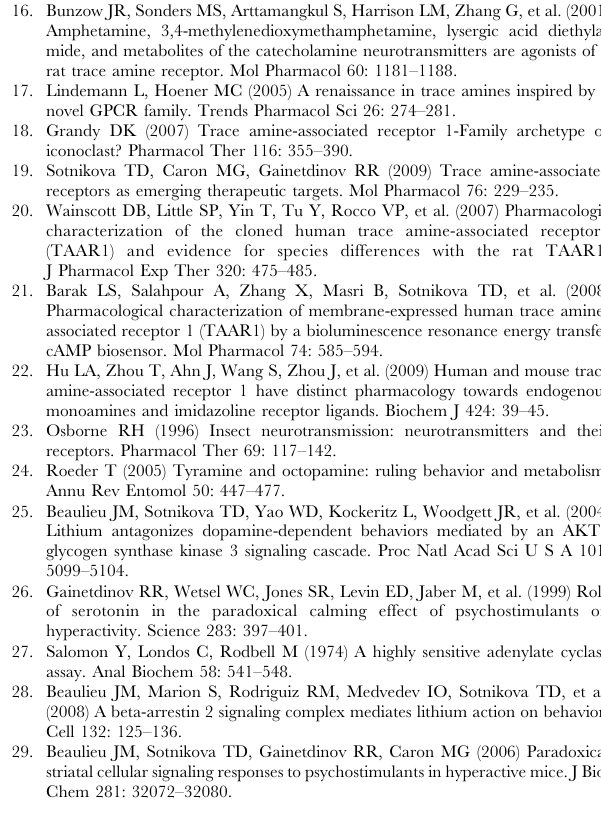
Figure S1 Automated measures of dynamics of abnormal movements induced by 3-MT in wild type mice. Found at: doi:10.1371/journal.pone.0013452.s001 (0.04 MB PDF) Figure S2 Determination of striatal extracellular levels of 3-MT after i.c.v. infusion of 3-MT (9 m g) into the lateral ventricle. Found at: doi:10.1371/journal.pone.0013452.s002 (0.02 MB PDF) Video S1 Examples of abnormal motor behaviors induced by 3- MT (36 m g, i.c.v.) in wild type mice (40 minutes after administration). Found at: doi:10.1371/journal.pone.0013452.s003 (6.70 MB MPG) Video S2 Examples of abnormal motor behaviors induced by 3- MT (36 m g, i.c.v.) in wild type mice (40 minutes after administration).